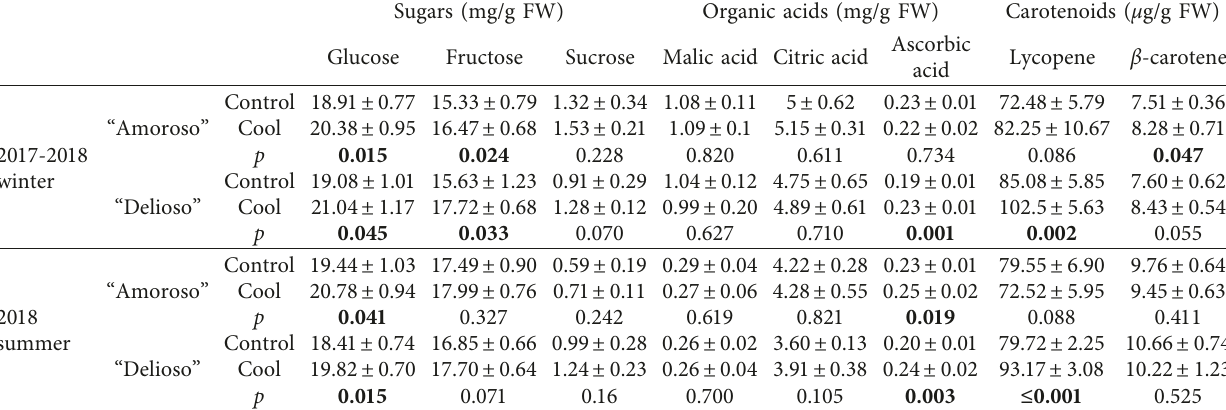
Table 3: Effects of root cooling on sugar, organic acid, and carotenoid concentrations of cocktail tomato fruits. Sugars (mg/g FW) Organic acids (mg/g